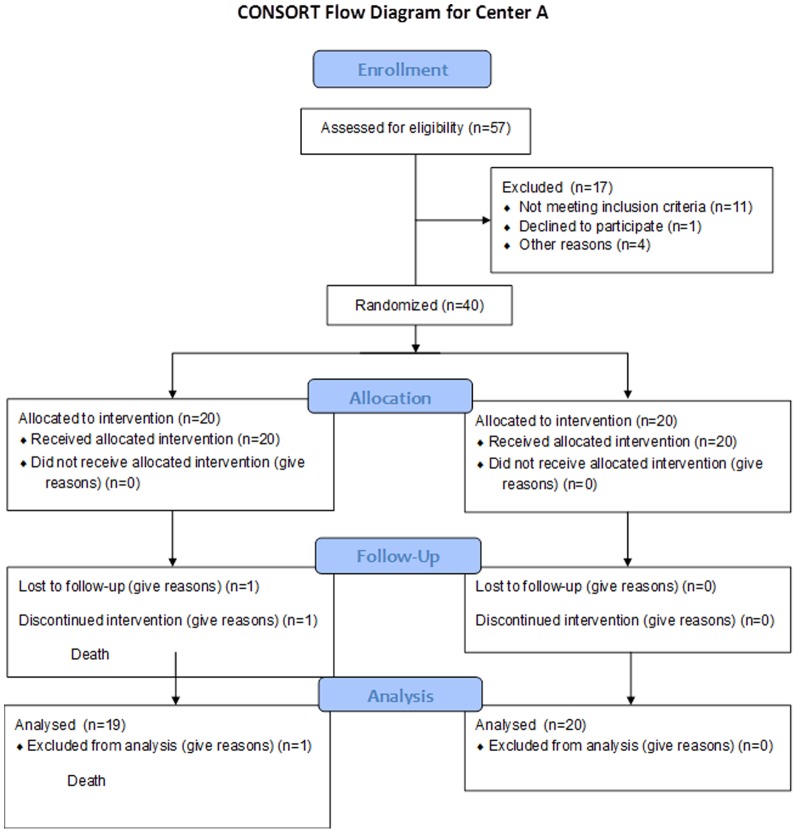
CONSORT diagram for center A.Assessment of Eligibility and Inclusion in the Inhaled Nitric Oxide for Attenuating Liver Allograft Injury Study at Center A.